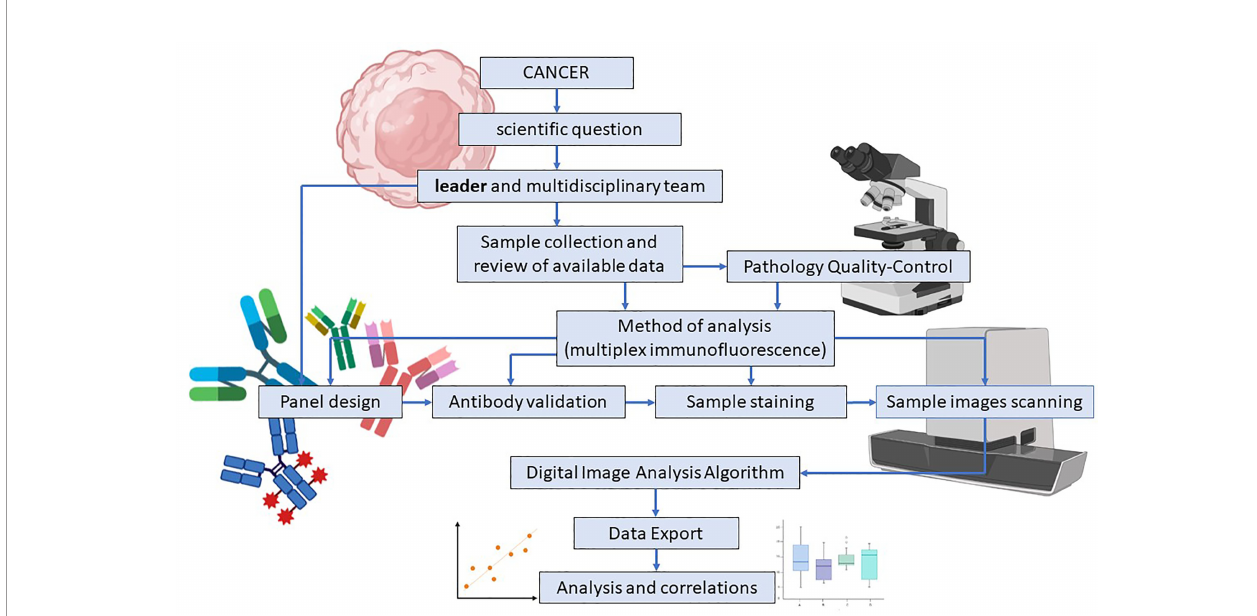
FIGURE 3 | Study and multiplex immuno fl uorescence panel design in translational research. Multiplex Immuno fl uorescence (mIF) panel design for translational research starts with a scienti fi c question and a multidisciplinary team guided by a scienti fi c leader who addresses their skills and efforts to accomplish the research goal. Sample collection, data review, and pathologist quality control are simultaneously applied to determine the study ’ s feasibility. Antibody validation is an essential part of the process and assures that the expressed surface proteins and their intensity are correctly detected. High-resolution image scanning provides high-quality images for analysis purposes. Finally, when the image analysis algorithm is applied, data results are exported, analyzed, and correlated. Image created with